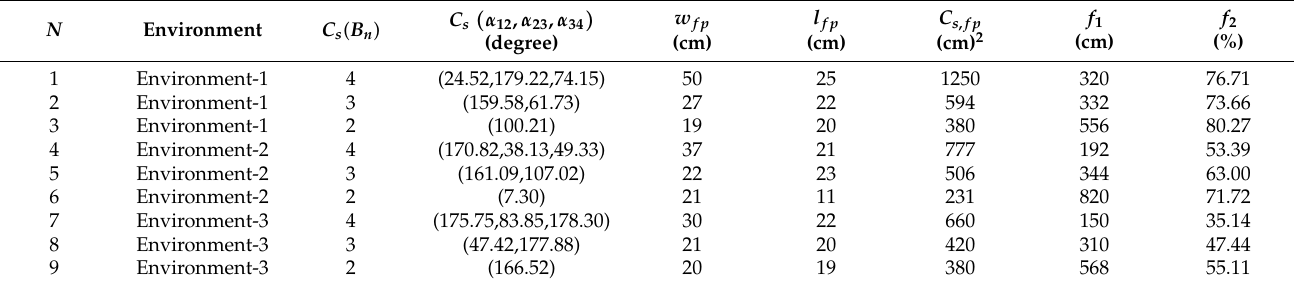
Table 4. Random configuration taken from the design